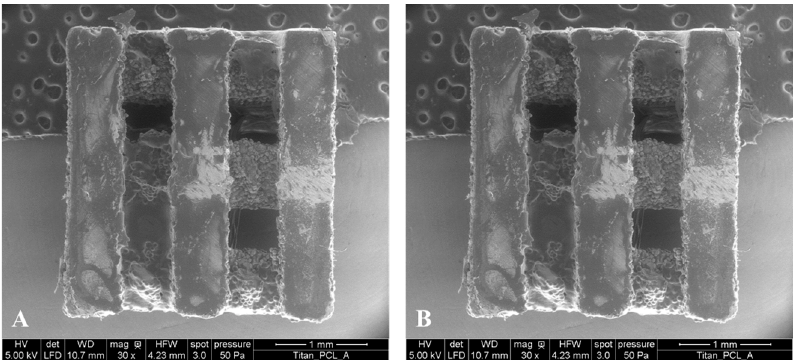
Figure 12. Environmental Scanning Electron Microscopy (ESEM) (Quanta FEG 250, FEI, Eindhoven, The Netherlands) images of PCL coated titanium ( A ) and PCL coated magnesium implants ( B ). After fixing the implants, the scanning electron micrographs were performed at 50 Pa pressure, moisturized atmosphere and an accelerating voltage of 10 kV (HV = high voltage; det = detector; LFD = large field detector; WD = working distance, HFE = horizontal field width, mag = magnification).